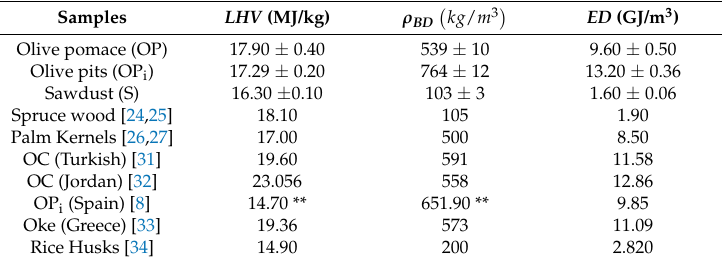
Table 3. Energy contents in the raw